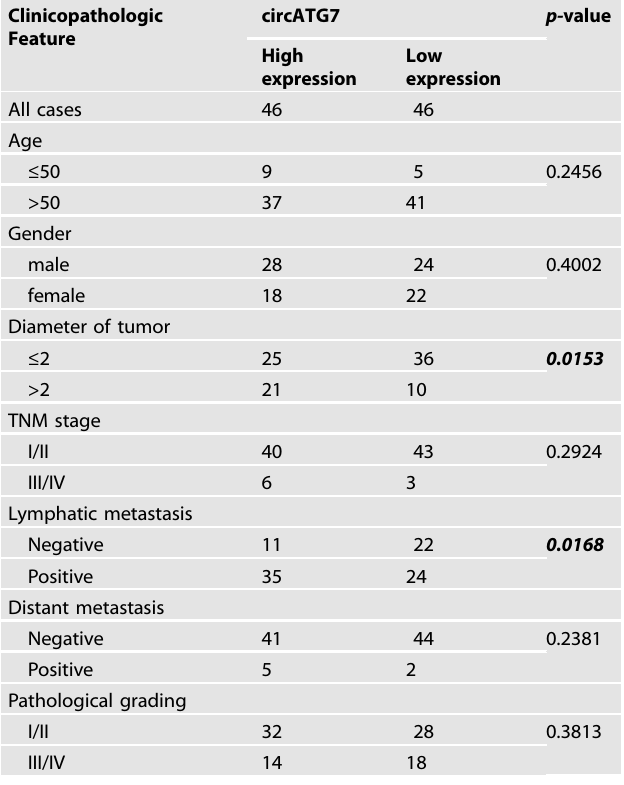
Table 1. The relationship between circATG7 expression and PC clinical